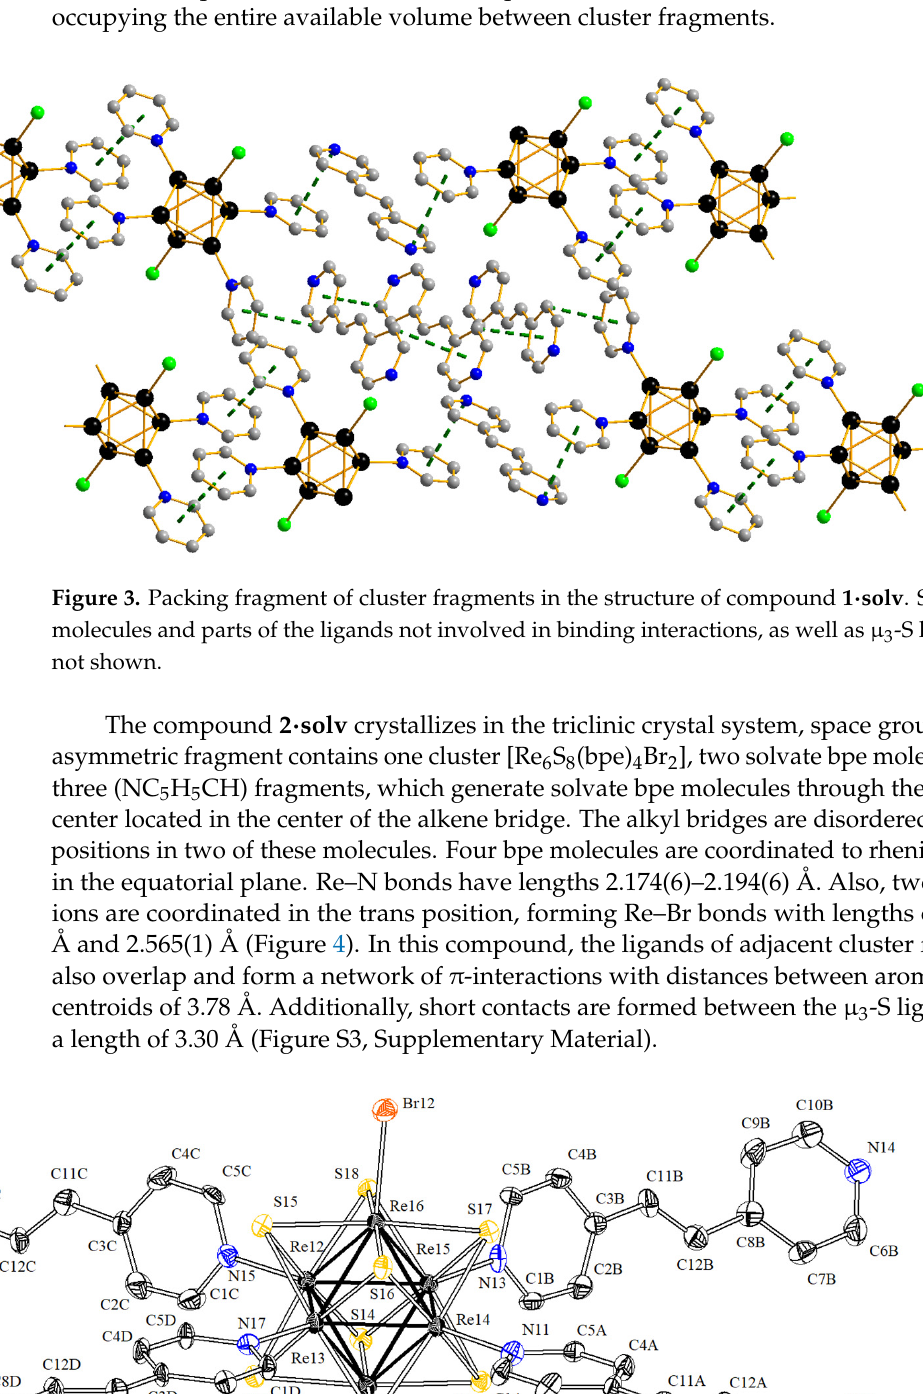
Figure 4. Molecular cluster [Re 6 S 8 (bpe) 4 Br 2 ] in the structure of compound 2·solv .